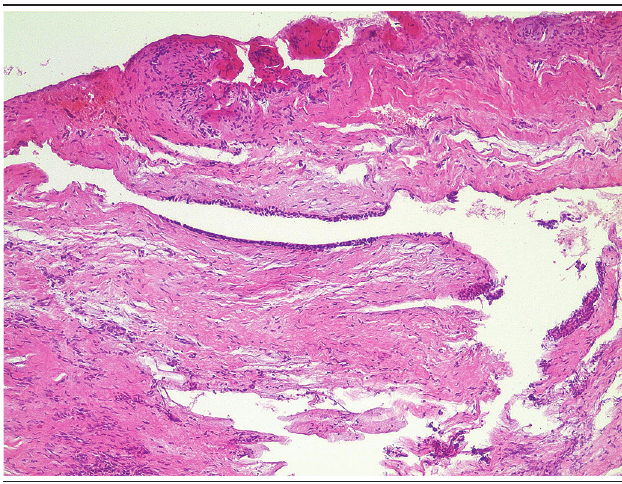
figurE 7 − Photomicrography of case 1 showing cystic cavity covered by epithelium (HE, 100×) HE: hematoxylin and eosin.